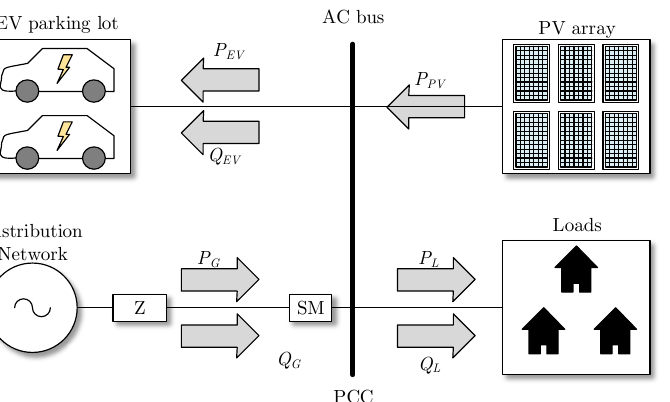
Figure 1. Typical AC microgrid structure composed of PV arrangement, loads, and EV parking